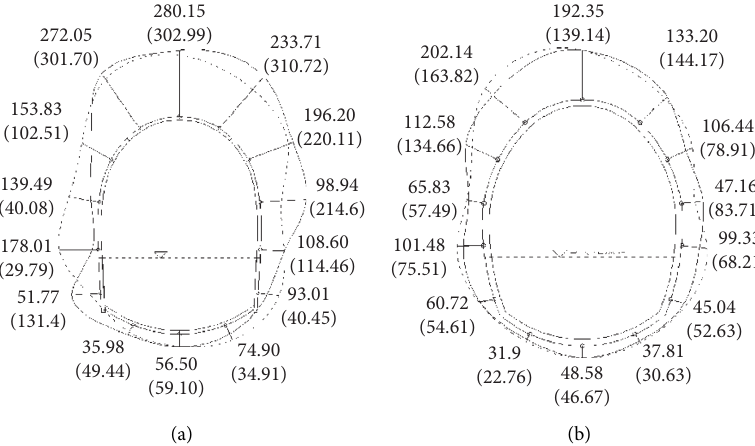
Figure 12: Distribution of steel frame’s stress of initial support on the cross-section A (unit: MPa). (a) Section A. (b) Section